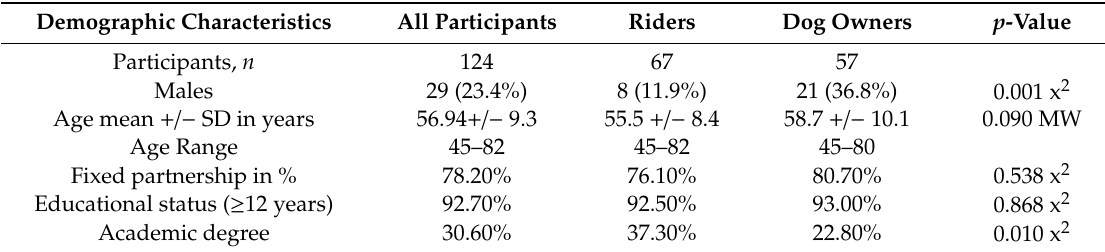
Table 1. Demographic characteristics of all participants and according to study groups.